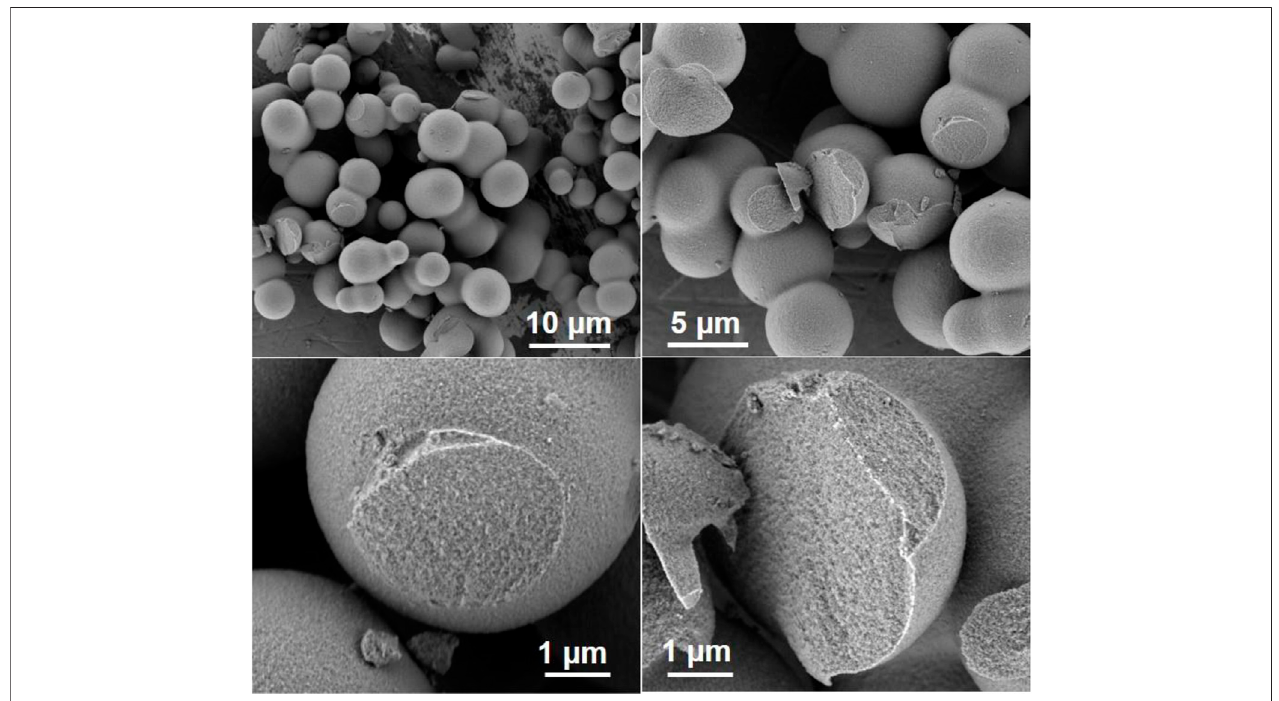
FIGURE 9 | Spherical silica similar to those obtained from Martens et al. (2011) via modi fi ed recipe of zeotile-4 using P85.